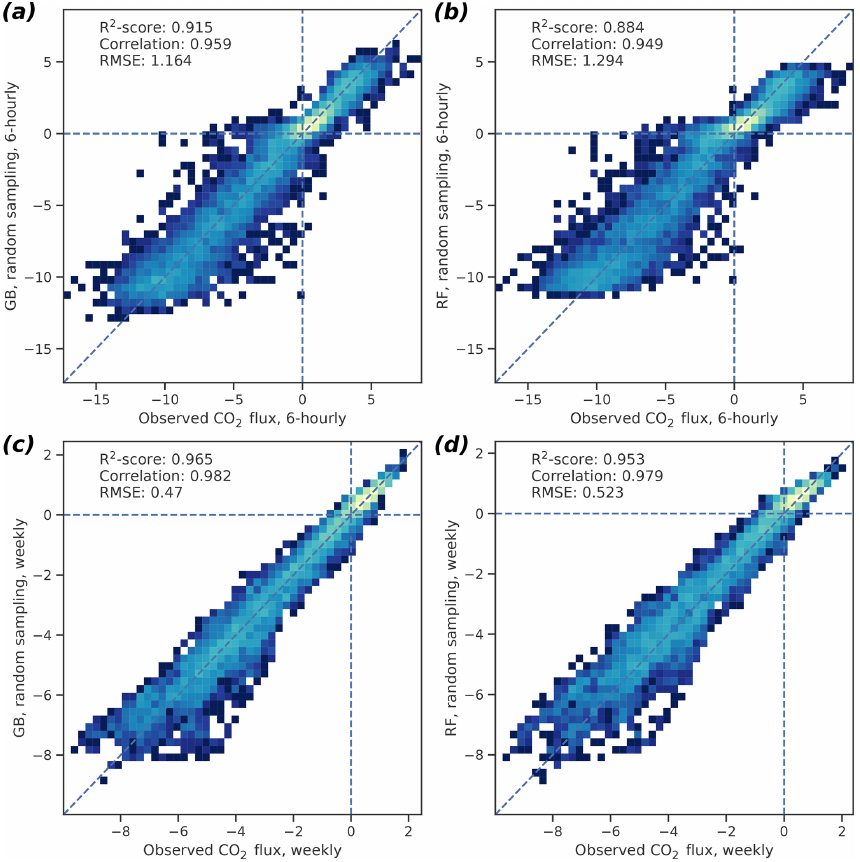
Figure 3. Two-dimensional probability density histograms of the 6h (a, b) and weekly mean (c, d) observed and cross-validated modeled CO 2 fluxes (GB shown in a, c ; RF in b, d ). Color shading indicates qualitatively the density of the observed–modeled value pairs inside each pixel. Bootstrap-estimated medians of R 2 scores, Pearson correlation coefficients, and the root mean square errors of the fit are also shown. See text for the confidence limits of these